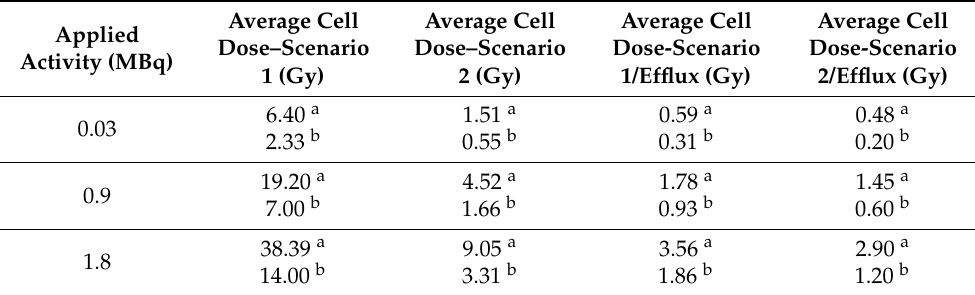
Table 2. Cell dose assessment for the different scenarios considered for 177 Lu-AuNP-SPTyr8 (clono- genic and MTT